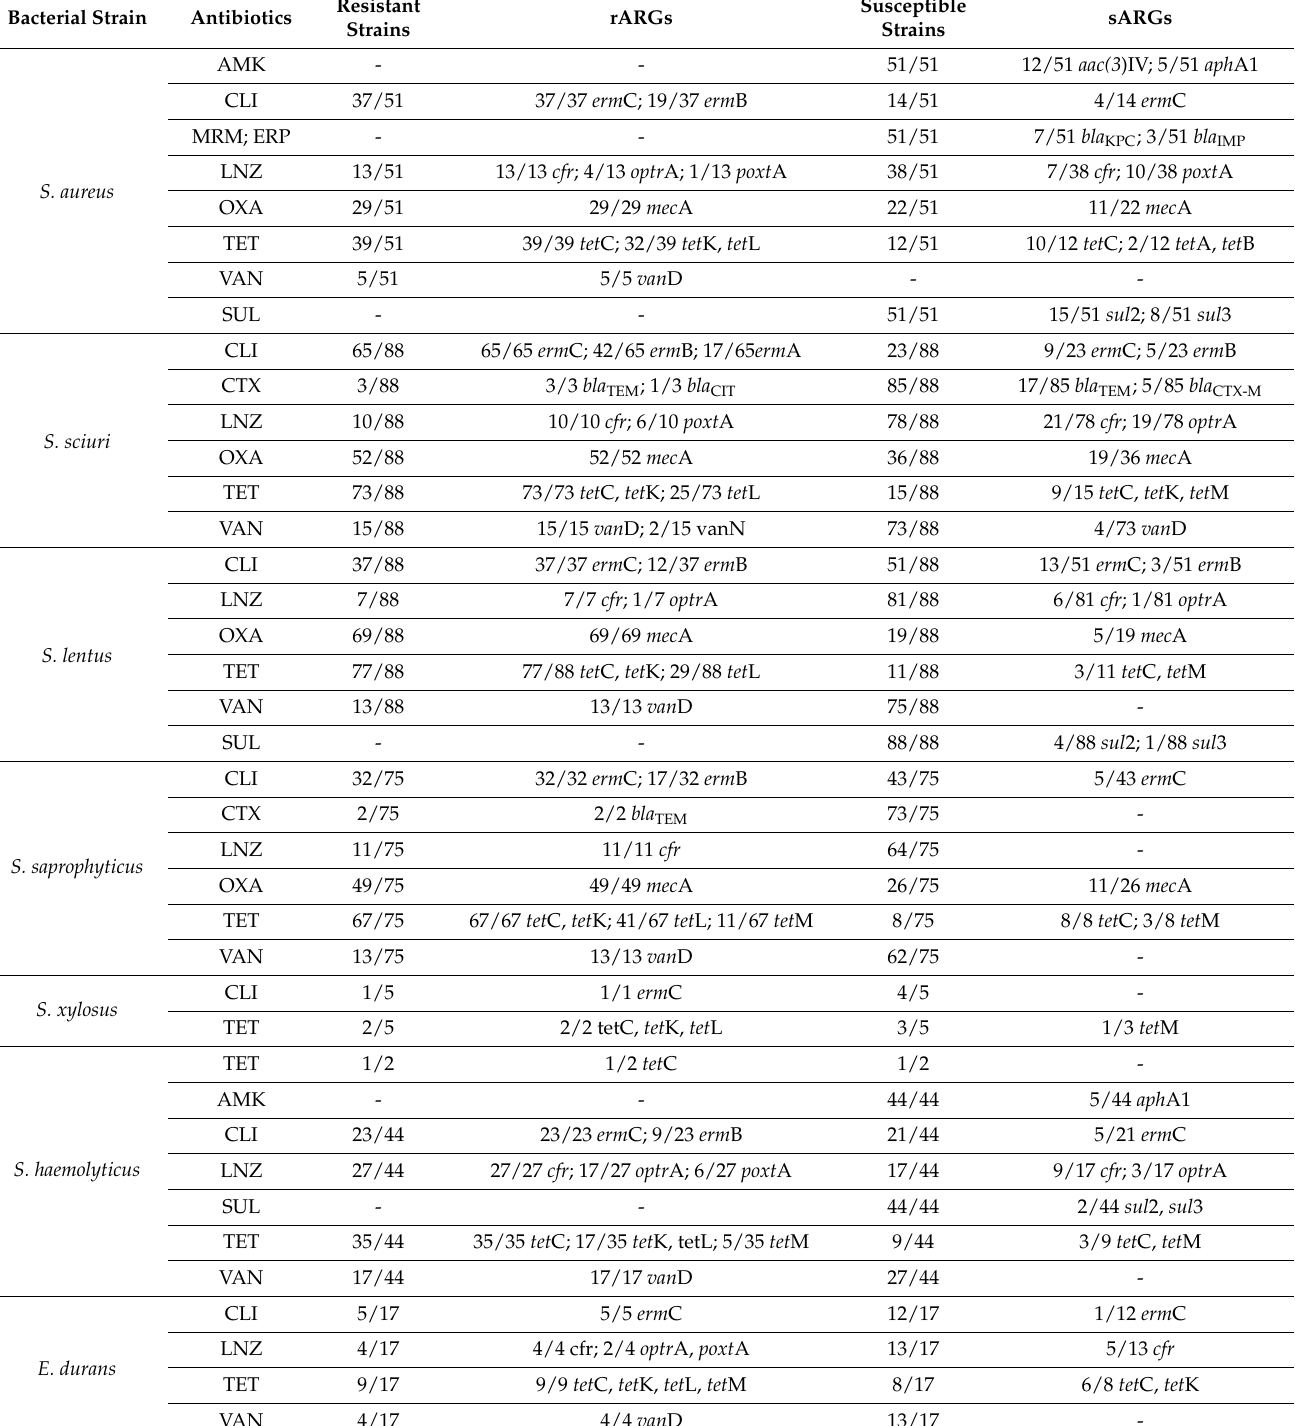
Table 8. ARGs detection from resistant and susceptible bacterial